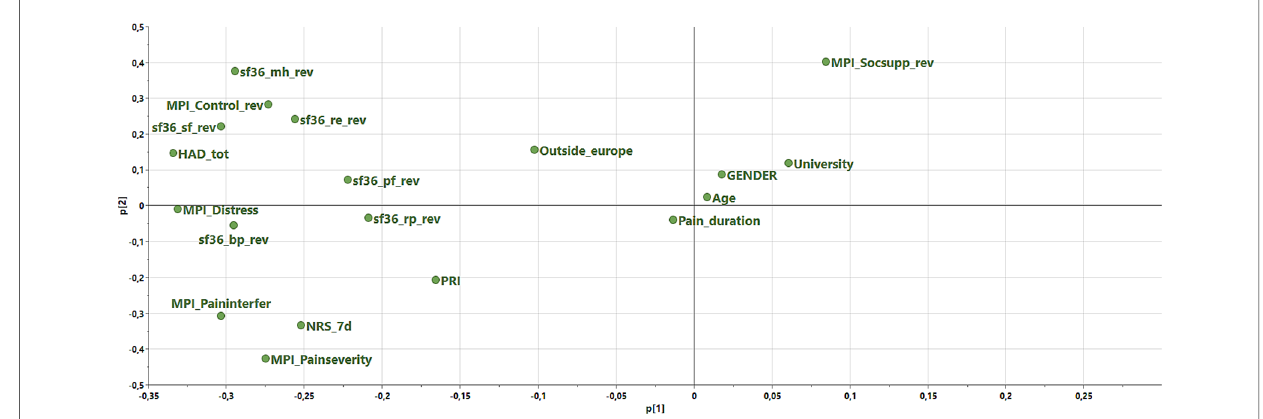
FIGURE 2 Loadings of a principal component analysis (PCA) of the included variables for the total cohort (N=40,184). Two components (p1 and p2) are shown. Note that some of the MPI variables and all sf36 variables were revised (indicated with _rev in the variable name) so that high values indicated a troublesome/negative situation. NRS_7d, Pain intensity according to a numeric rating scale; University, University education (binary variable); Outside_Europe, born outside Europe (binary variable), PRI, Pain region Index; HAD, The Hospital Anxiety and Depression Scale; HAD-tot, sum of the two subscales of HAD; MPI, Multidimensional Pain Inventory; MPI_Paininterfer, MPI Pain interference; MPI_Painseverity, MPI Pain severity; MPI_Socsupp, MPI Social support; sf36, The Short Form Health Survey; sf36_pf, sf36-physical function; sf36_rp, sf36-role physical; sf36_bp, sf36- bodily pain; sf36_sf, sf36-social function; sf36_re, sf36-role emotional; sf36_mh, sf36-mental